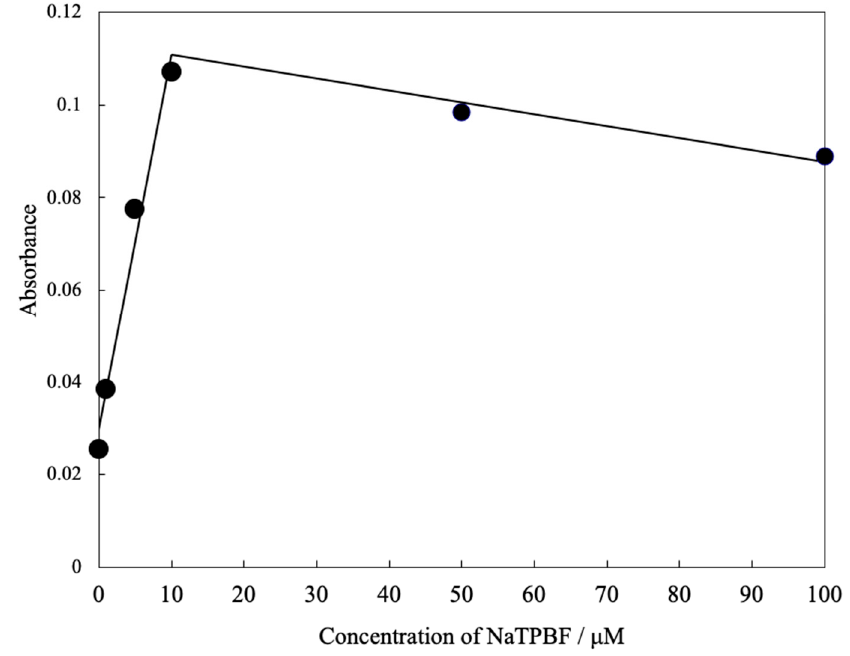
Figure 2. Calibration curve for NaTPBF obtained by using an L-RB-based optode.